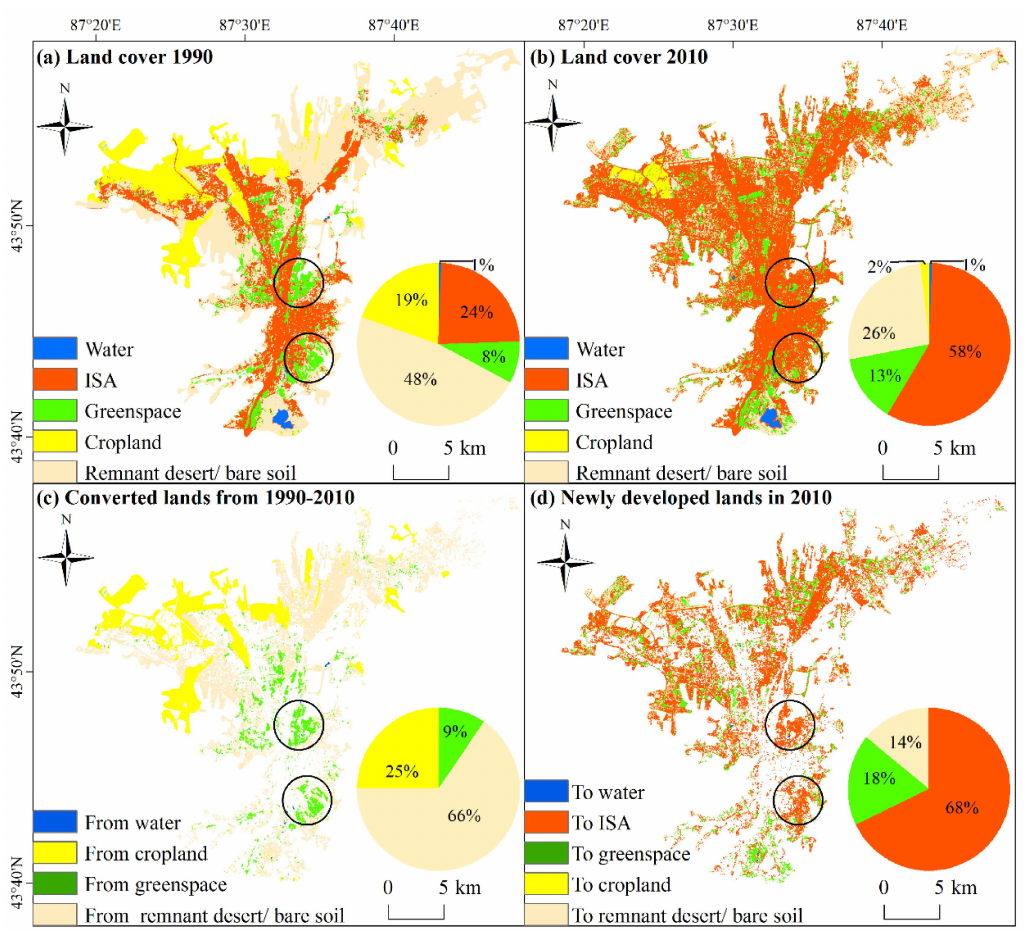
Figure 4. The land-cover types of Urumqi in 1990 ( a ) and 2010 ( b ), and the conversion from 1990 to 2010 ( c and d ). The circled areas indicate the two large downtown parks that disappeared in 2010. ISA indicates the impervious surface